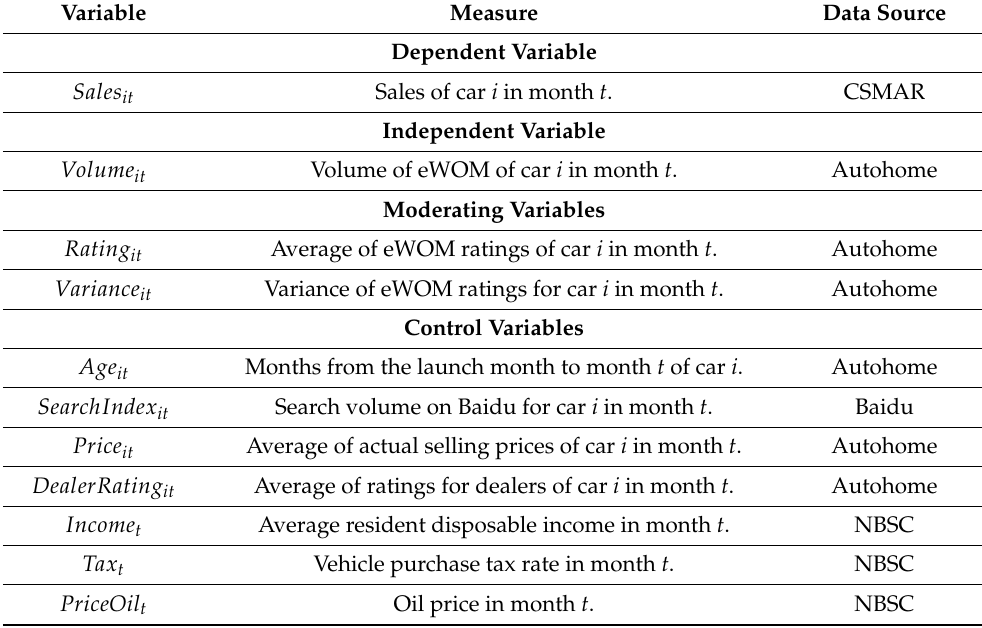
Table 3. Definitions of main variables and data